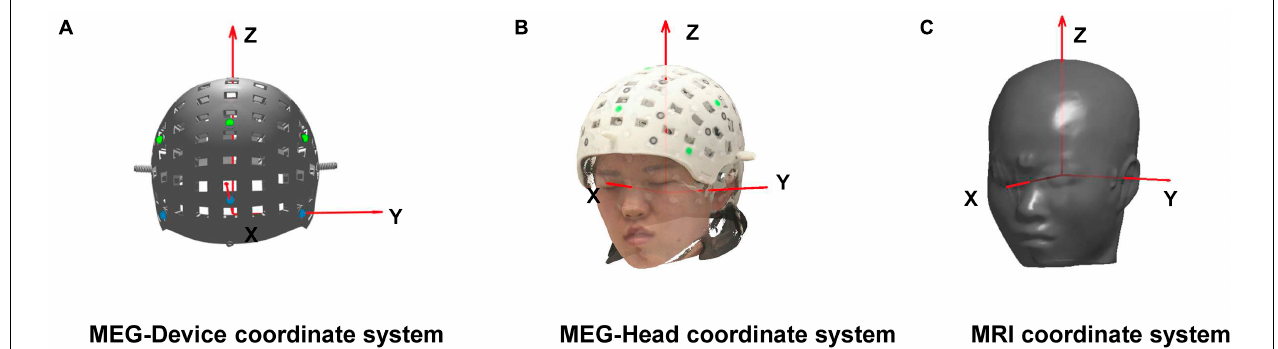
FIGURE 1 | (A) The magnetoencephalography (MEG)-Device coordinate system is defined during designing the helmet. Here, the origin of the MEG-Device coordinates is the midpoint of the left and right blue markers. The X-axis points to the front blue marker, and the Y-axis points to the left blue marker. (B) The MEG-Head coordinate system is defined based on the nasion point, left and right pre-auricular points, which are chosen in the optical scanning or digital results. The X-axis points to the nasion point when the Y-axis points to the left ear point. (C) The magnetic resonance imaging (MRI) coordinate system is defined based on the three fiducial points: nasion point, left and right pre-auricular points, which are marked on the MRI slices. The origin of the MRI coordinates is the midpoint of the left and right pre-auricular points, and the X-axis points to the nasion point when the Y-axis points to the left pre-auricular point. All coordinate systems follow the right-hand